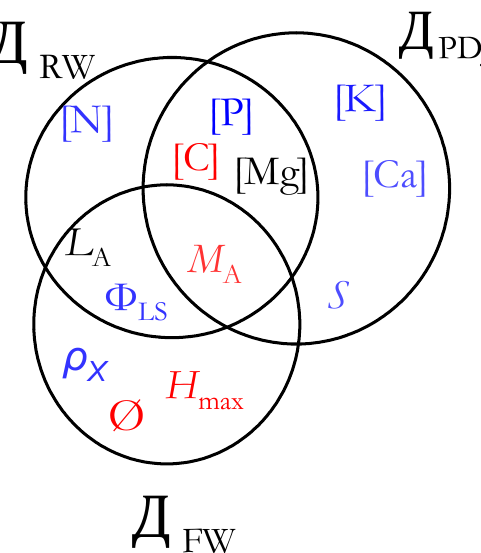
Fig. 7. Euler diagram showing overlaps between the first three dimensions for the individual measured traits (where significant): blue; positive relationship with dimension, red; negative relation- ship with dimension, black; of different sign depending on the di- mension. Abbreviations are as in Table 5, with the three trait di- mensions as defined in Sect. 3.5